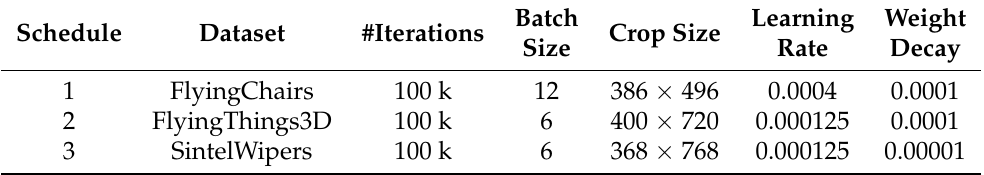
Table 1. Training Schedule for